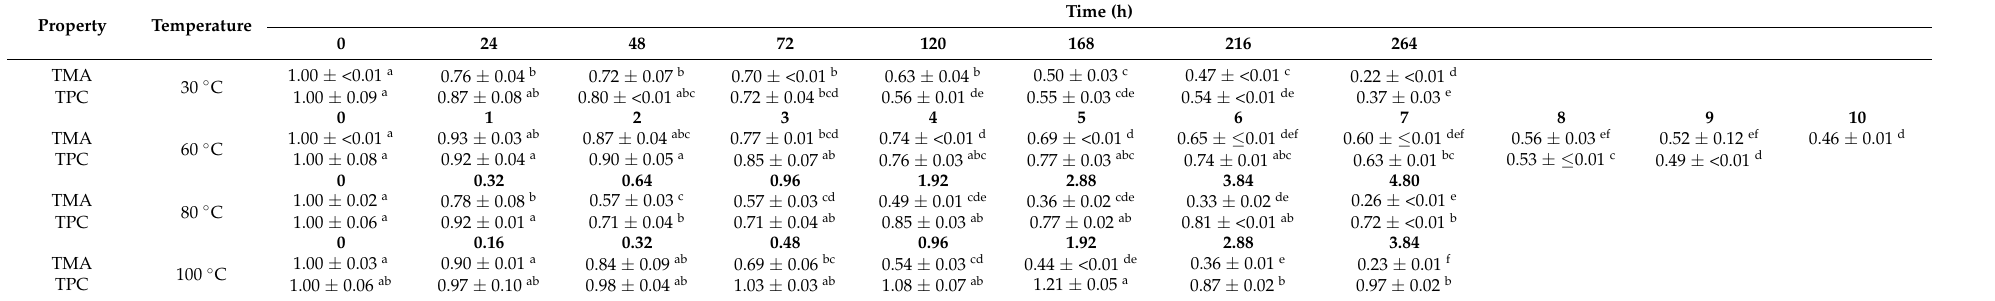
Table 2. Normalized values of TMA and TPC degradation by thermal